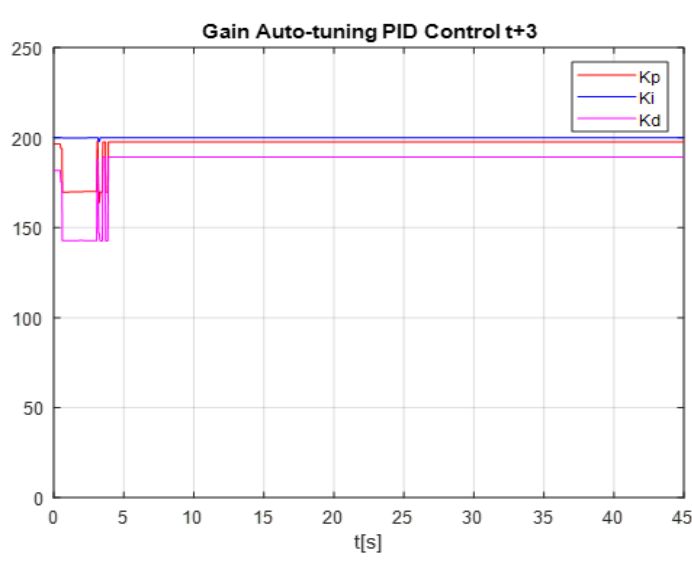
Figure 22. Gain PID auto